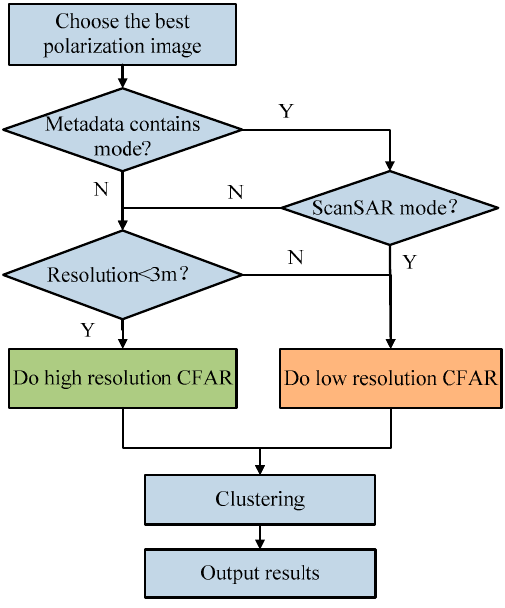
Figure 3. Detailed flow of ship candidate detection. Y (yes), N (no).